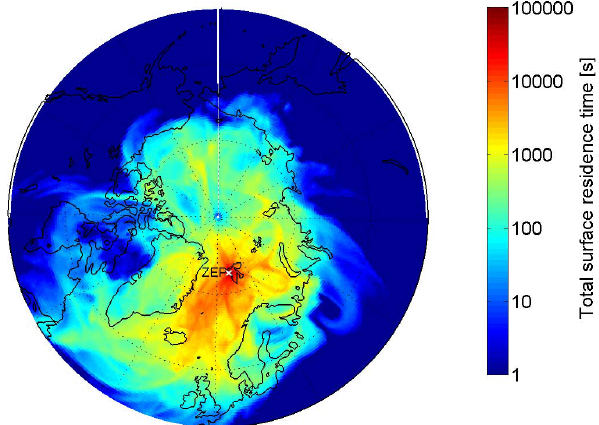
Fig. 5. Total surface residence time for the Zeppelin station (ZEP, see cross) for the period 15 July to 15 October